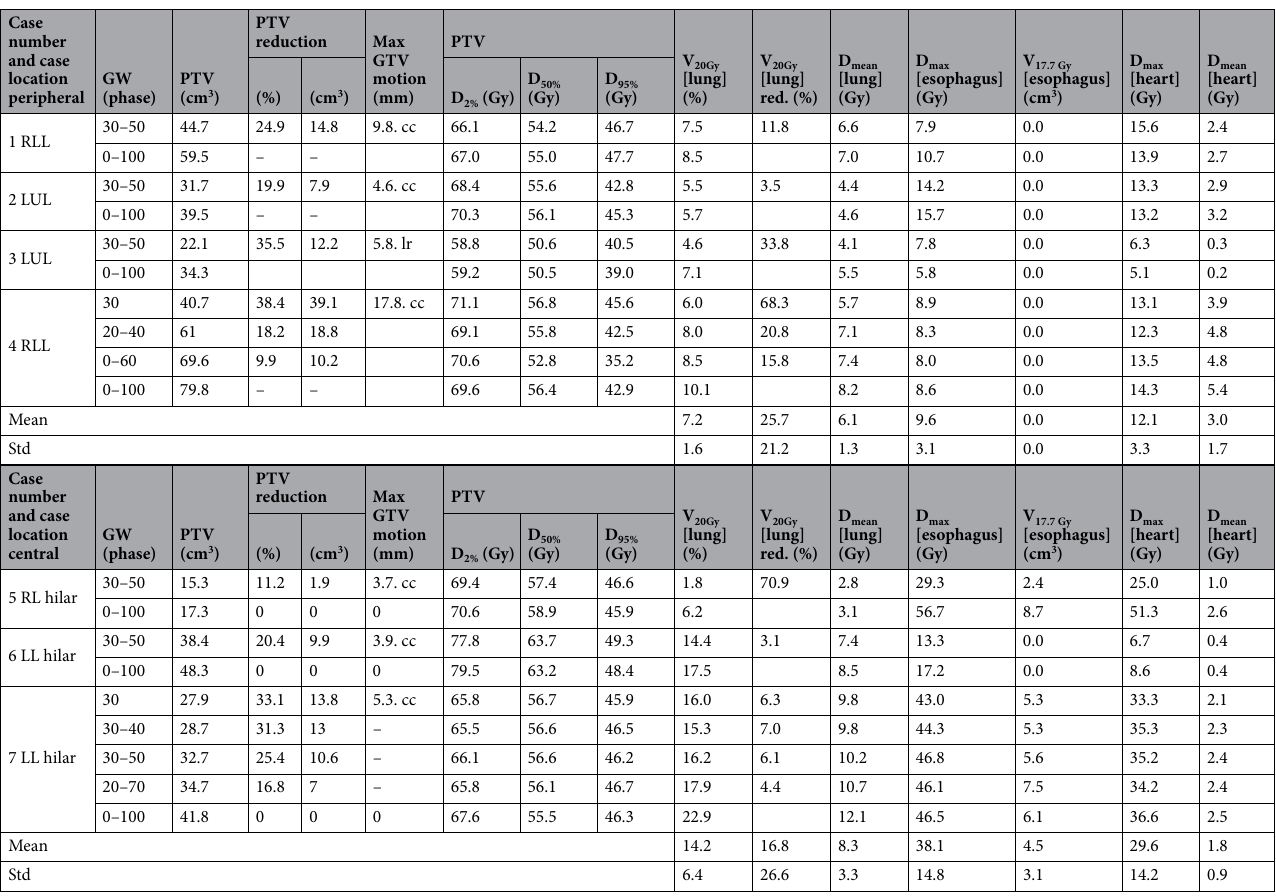
Table 2. Motion, PTV sizes, PTV reduction and dose parameters for peripheral and central tumor. Lung volume receiving 20 Gy V 20Gy [lung] for peripherally and centrally located lung tumors are reported. Maximum dose for the esophagus (D max [esophagus]) and V 17.7 Gy [esophagus] indicating the esophagus volume receiving 17.7 Gy are given. Maximum (D max [heart]) and mean heart doses (D mean [heart]) are reported. Cc stands for cranio-caudal and lr for left–right direction,